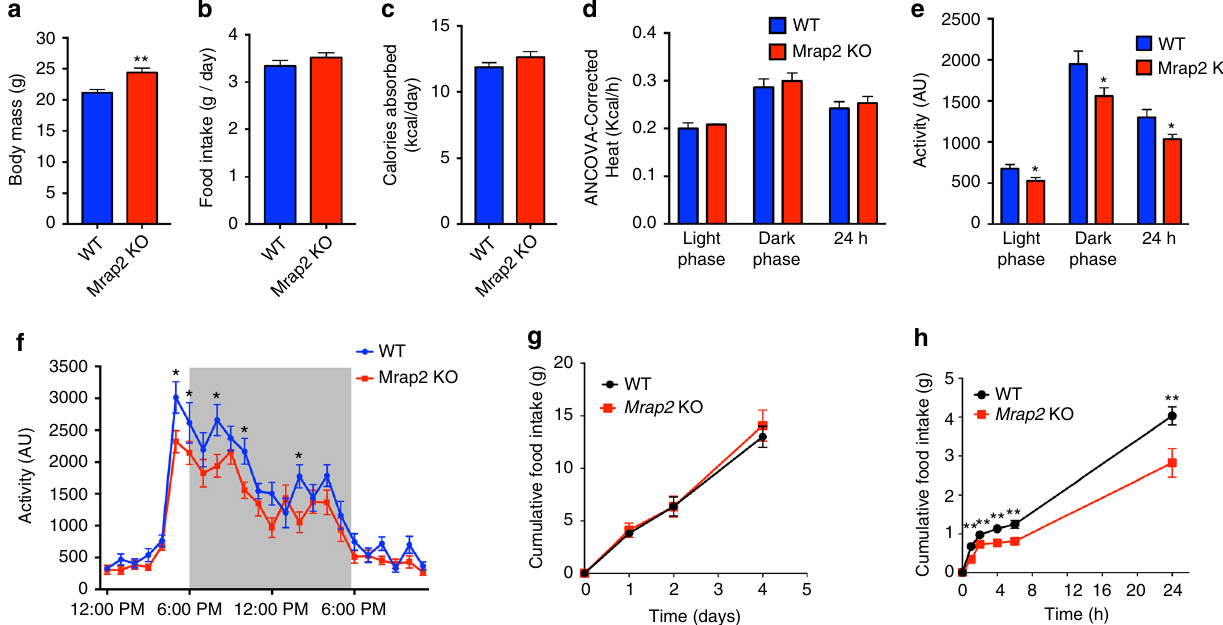
Fig. 1 Mrap2 KO mice display decreased locomotor activity. a Body mass of 12- to 13-week-old WT ( n = 12) and Mrap2 KO ( n = 13) male mice. b Daily food intake of WT and Mrap2 KO mice. c Daily calories absorbed by WT and Mrap2 KO mice. d ANCOVA-corrected energy expenditure of WT and Mrap2 KO mice. e Activity of WT and Mrap2 KO mice. f Hourly activity of WT and Mrap2 KO mice. g Cumulative food intake (regular diet) of WT and Mrap2 KO mice over 5 days. h Cumulative food intake (regular diet) of WT and Mrap2 KO mice after a 24 h fast. Error bars are SEM. * P < 0.05, ** P < 0.01 NATURE COMMUNICATIONS | 8: